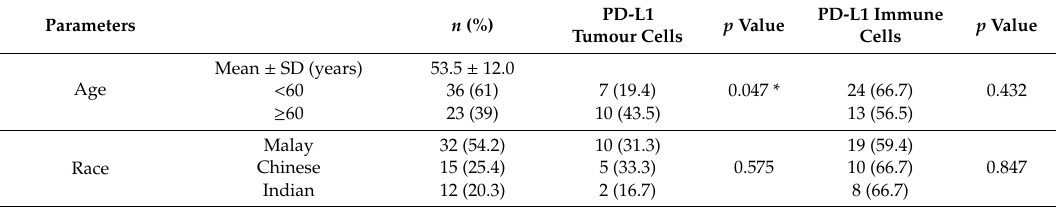
Demographic data with programmed death ligand 1 (PD-L1) expression profile in endometrial